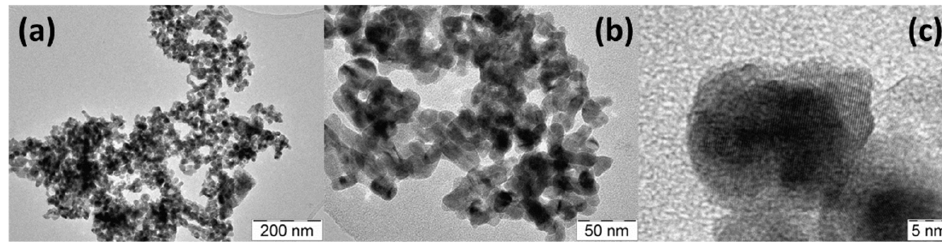
Figure 1. XRD pattern of the CuO-Ag/KB catalyst and CuO/KB catalyst.